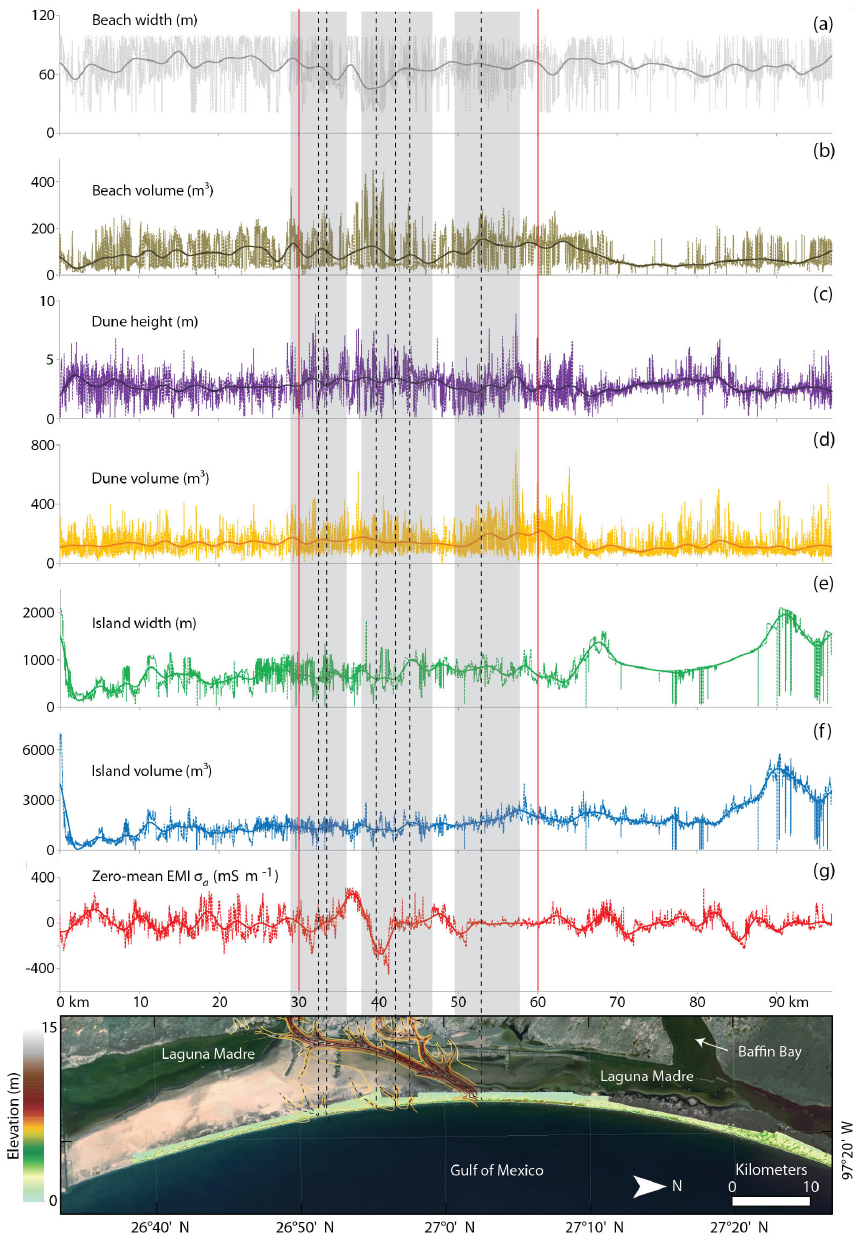
Figure 4. DEM metrics extracted from aerial lidar data. The sampling interval (step size) for each data series is 10m and the coordinates are matched with each EMI acquisition point. Each panel corresponds to (a) beach width, (b) beach volume, (c) dune height, (d) dune volume, (e) island width, (f) island volume, and (g) EMI σ a . The island is divided into three zones (red vertical lines) roughly indicating the locations within and outside the known paleo-channel region. A Savitzky–Golay smoothing filter was applied to all data series (lidar and EMI) using a moving window of n = 250 to highlight the large-scale patterns in each